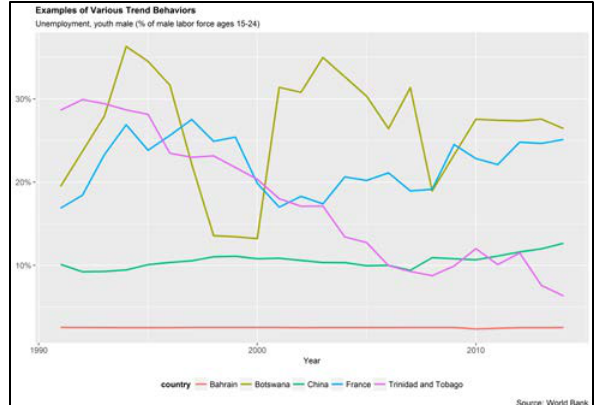
Figure 1. Examples of Various Trend Behaviours